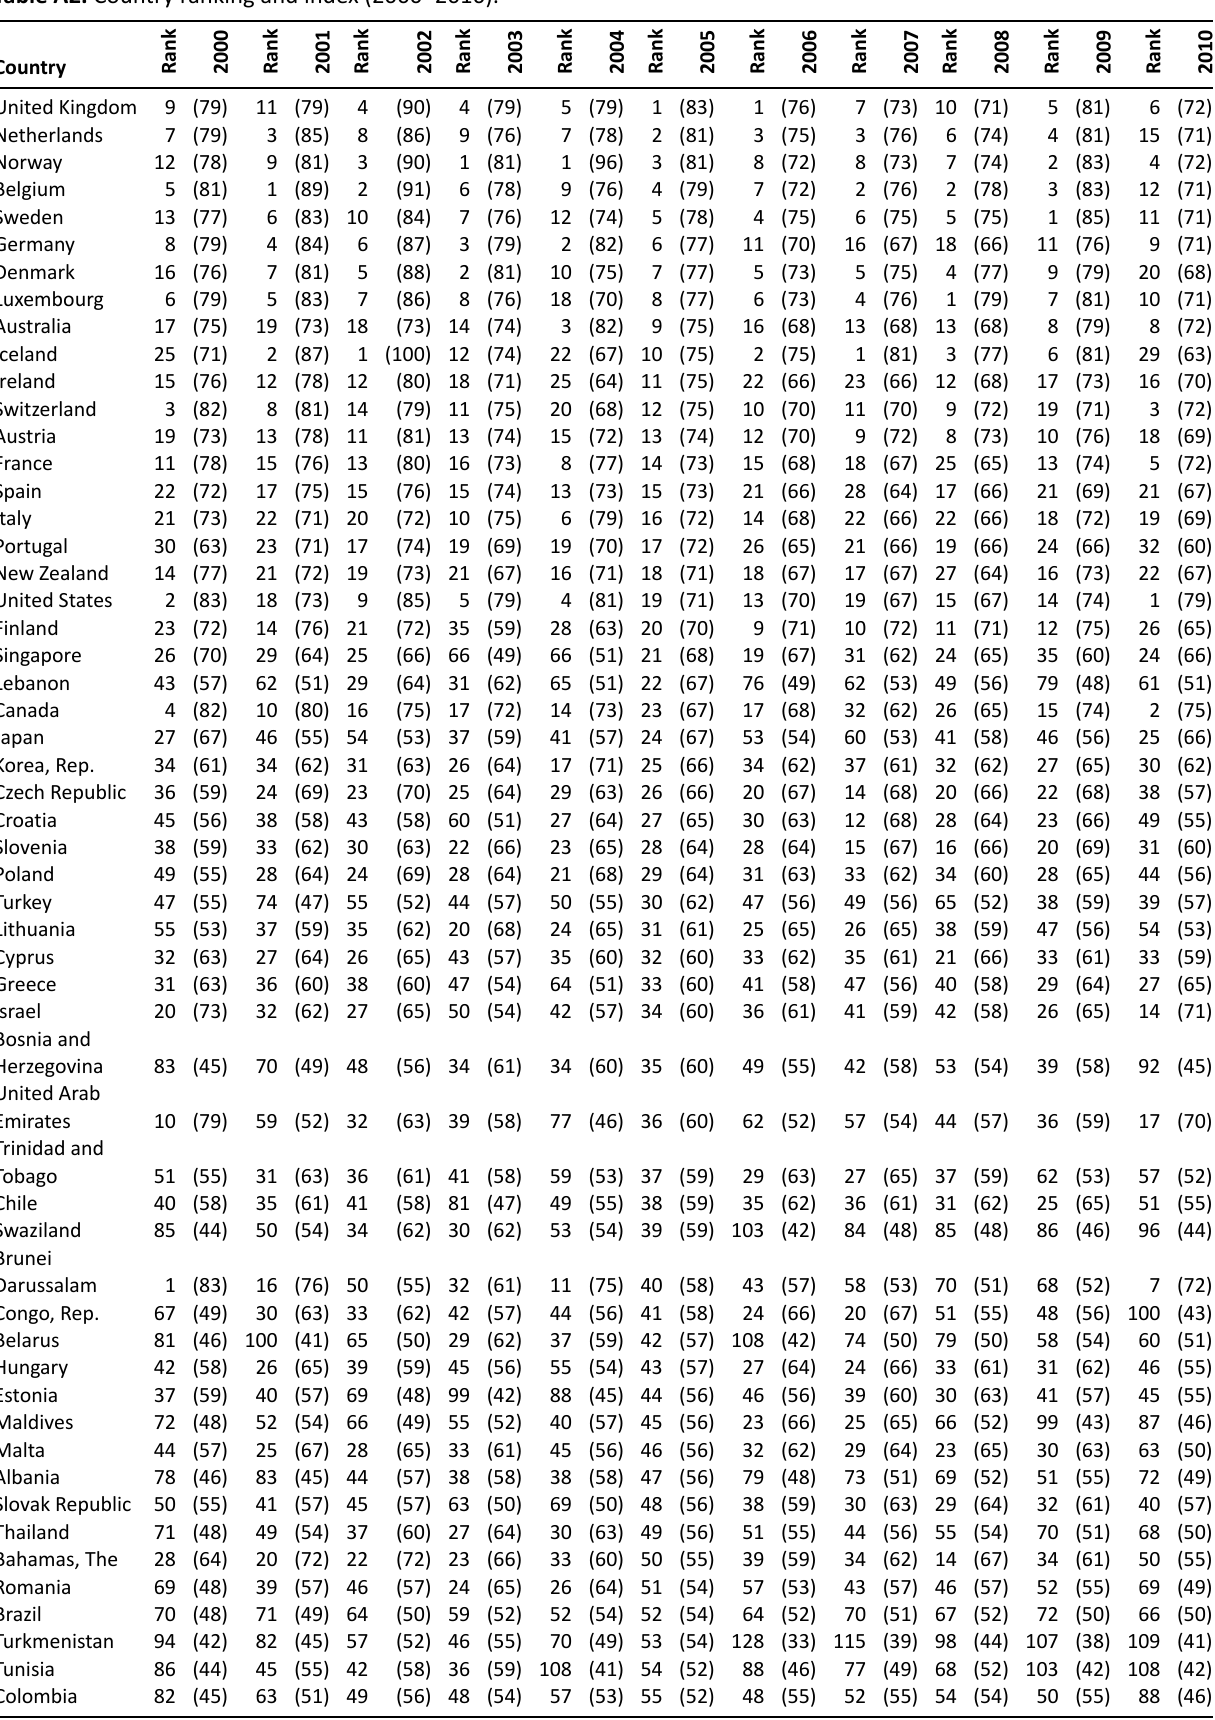
Table A2. Country ranking and index